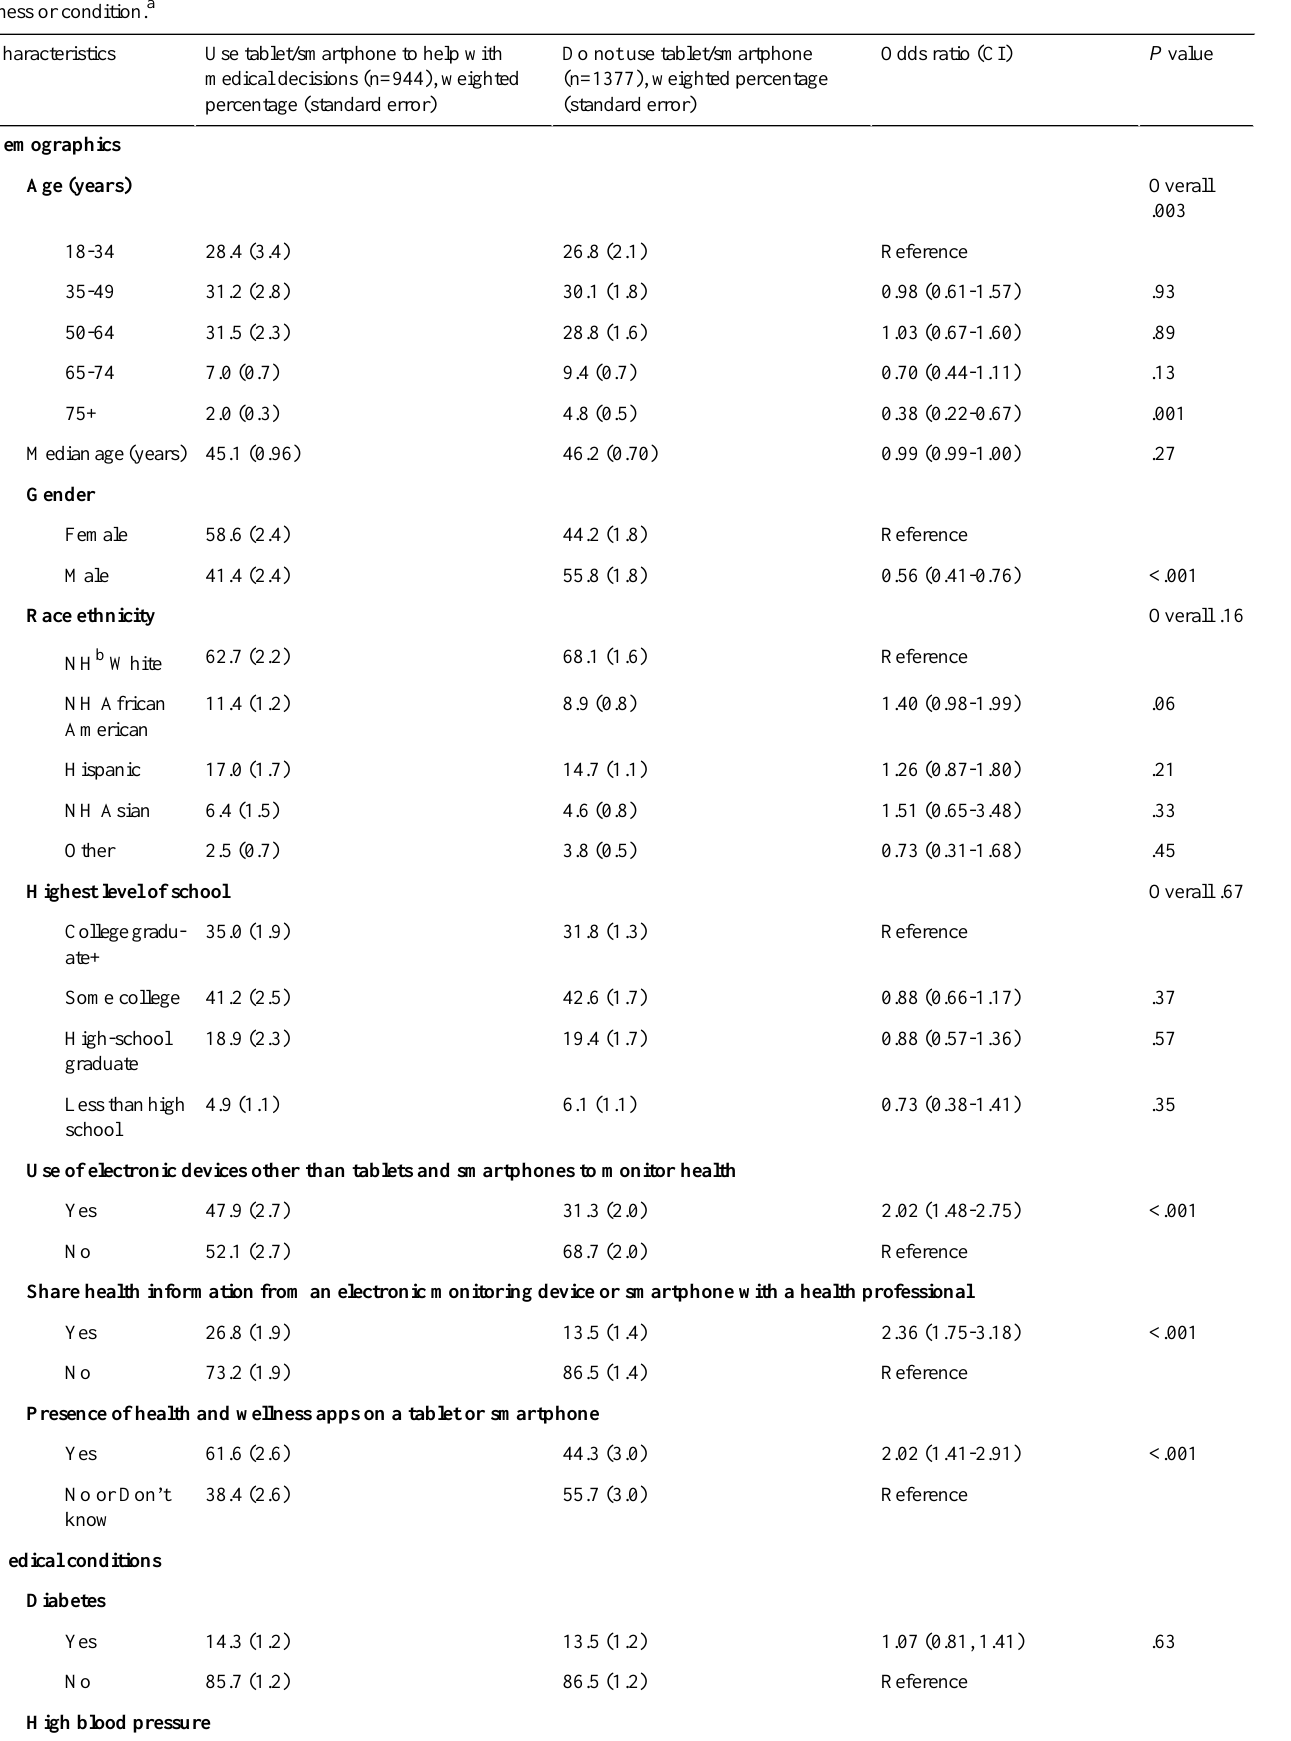
Table 1. Description of population estimates and univariate odds ratios for using tablet or smartphone to help make decisions about how to treat an illness or condition.